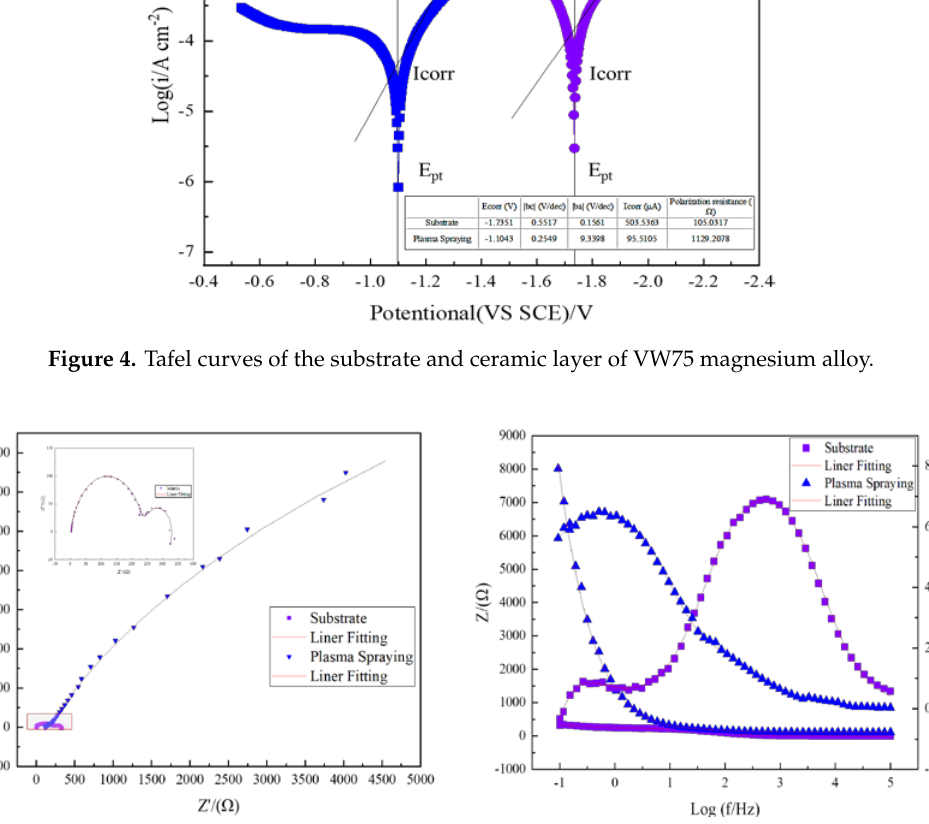
Figure 4. Tafel curves of the substrate and ceramic layer of VW75 magnesium alloy.